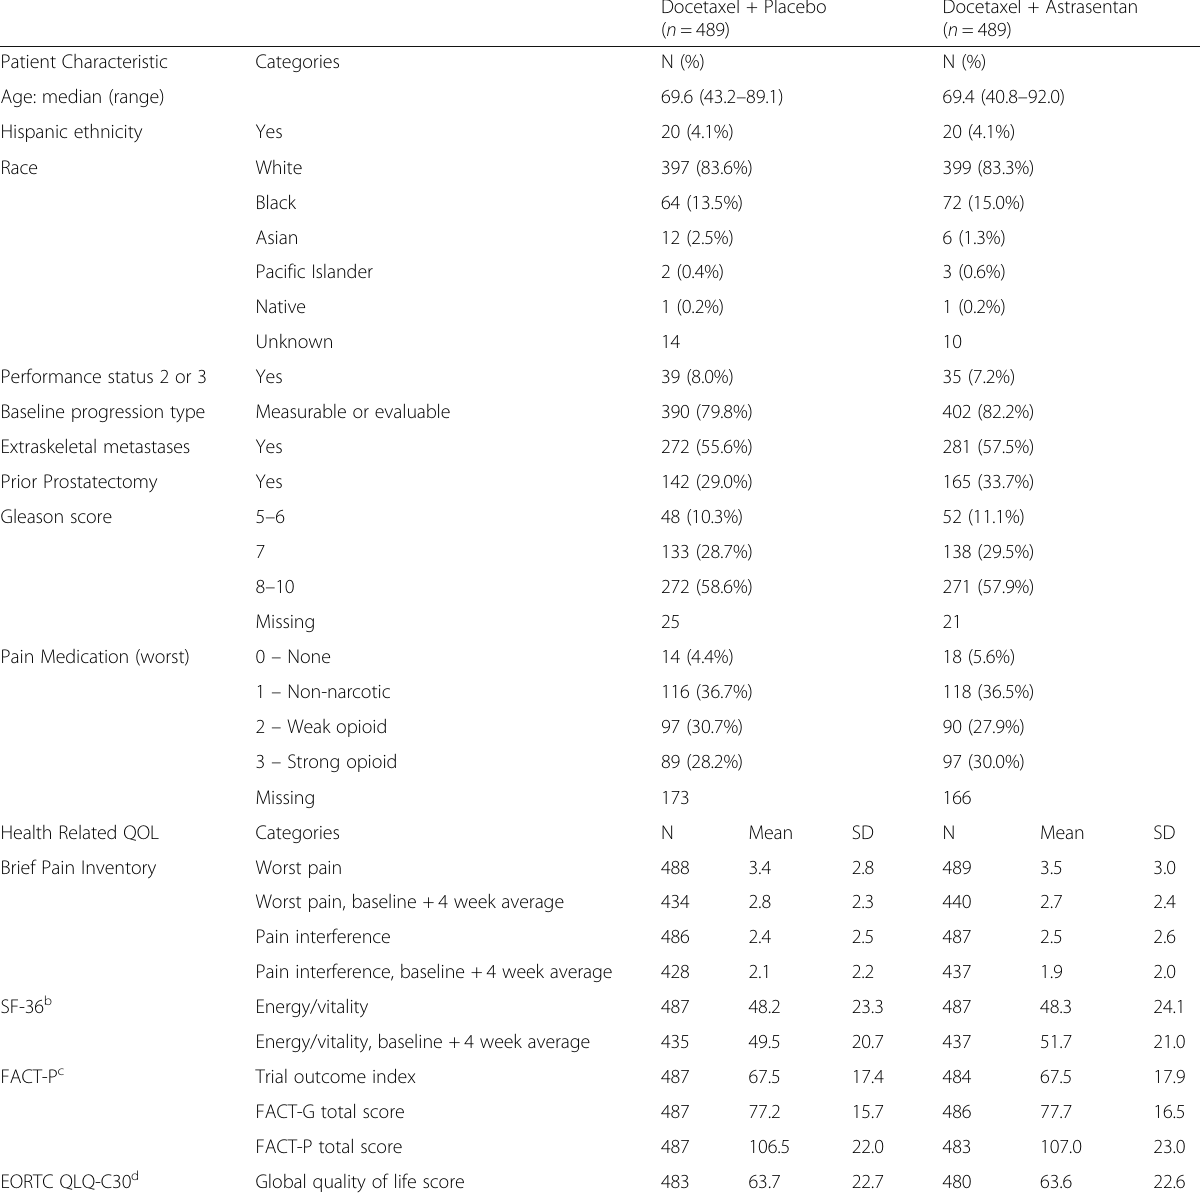
Table 1 Baseline Patient Characteristics and Baseline Health Related Quality-of-Life a